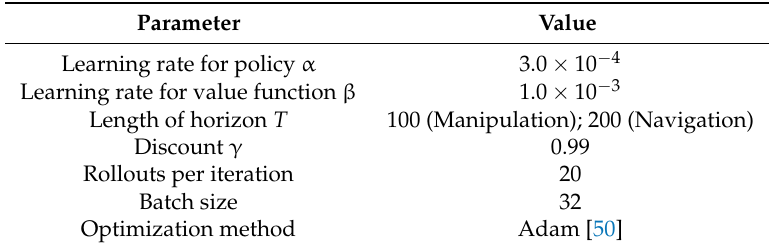
Table 1. Parameters in our